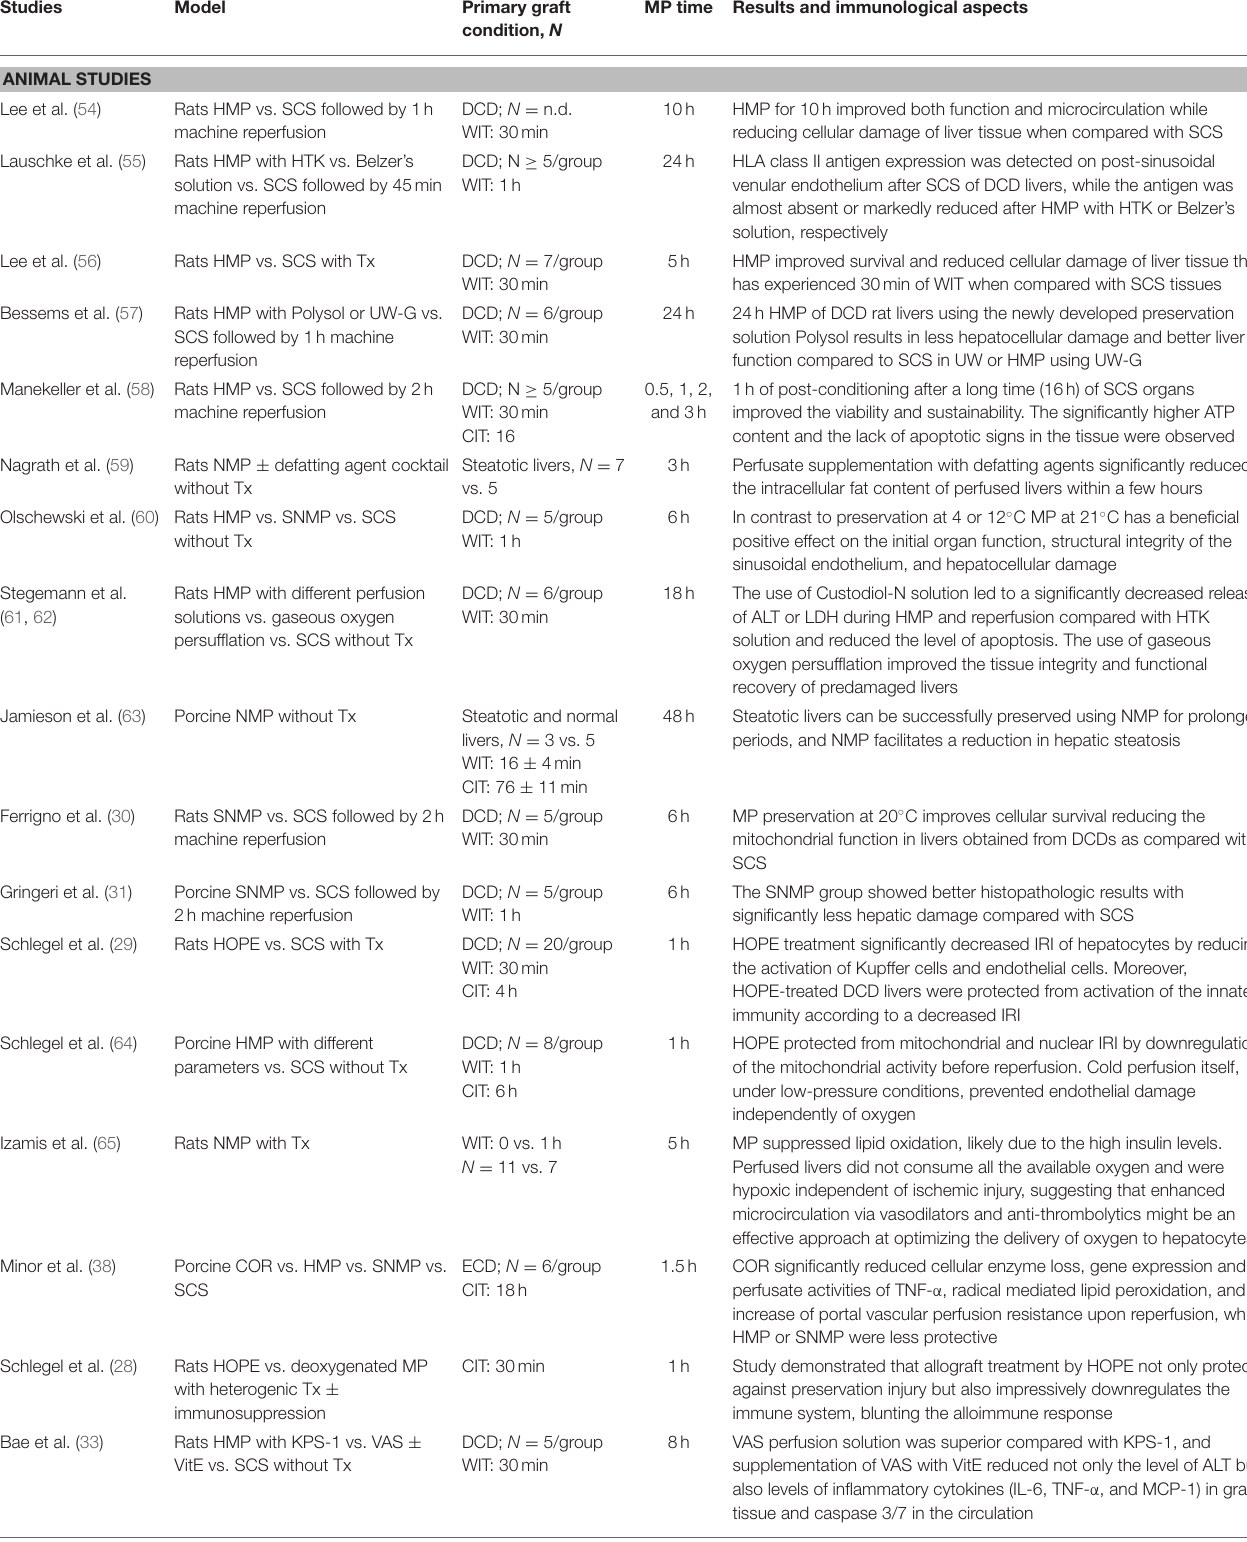
TABLE 2 | Experimental and clinical studies of machine perfusion of extended criteria donor liver